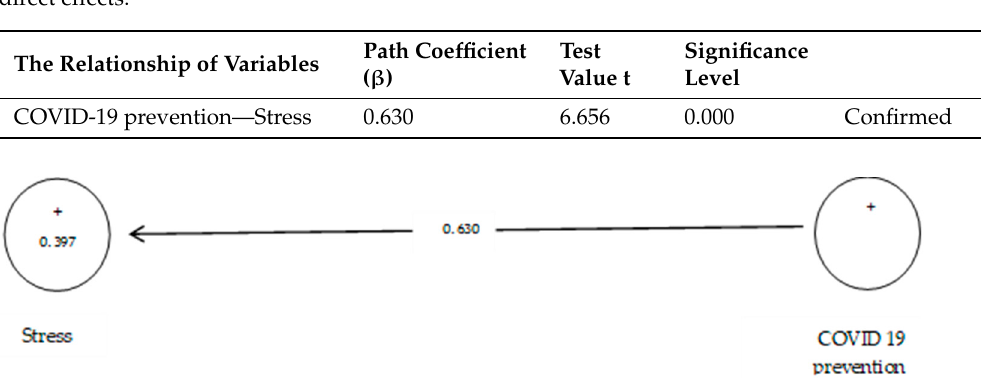
Figure 12. The fifth sub-hypothesis model includes factor load coefficients.